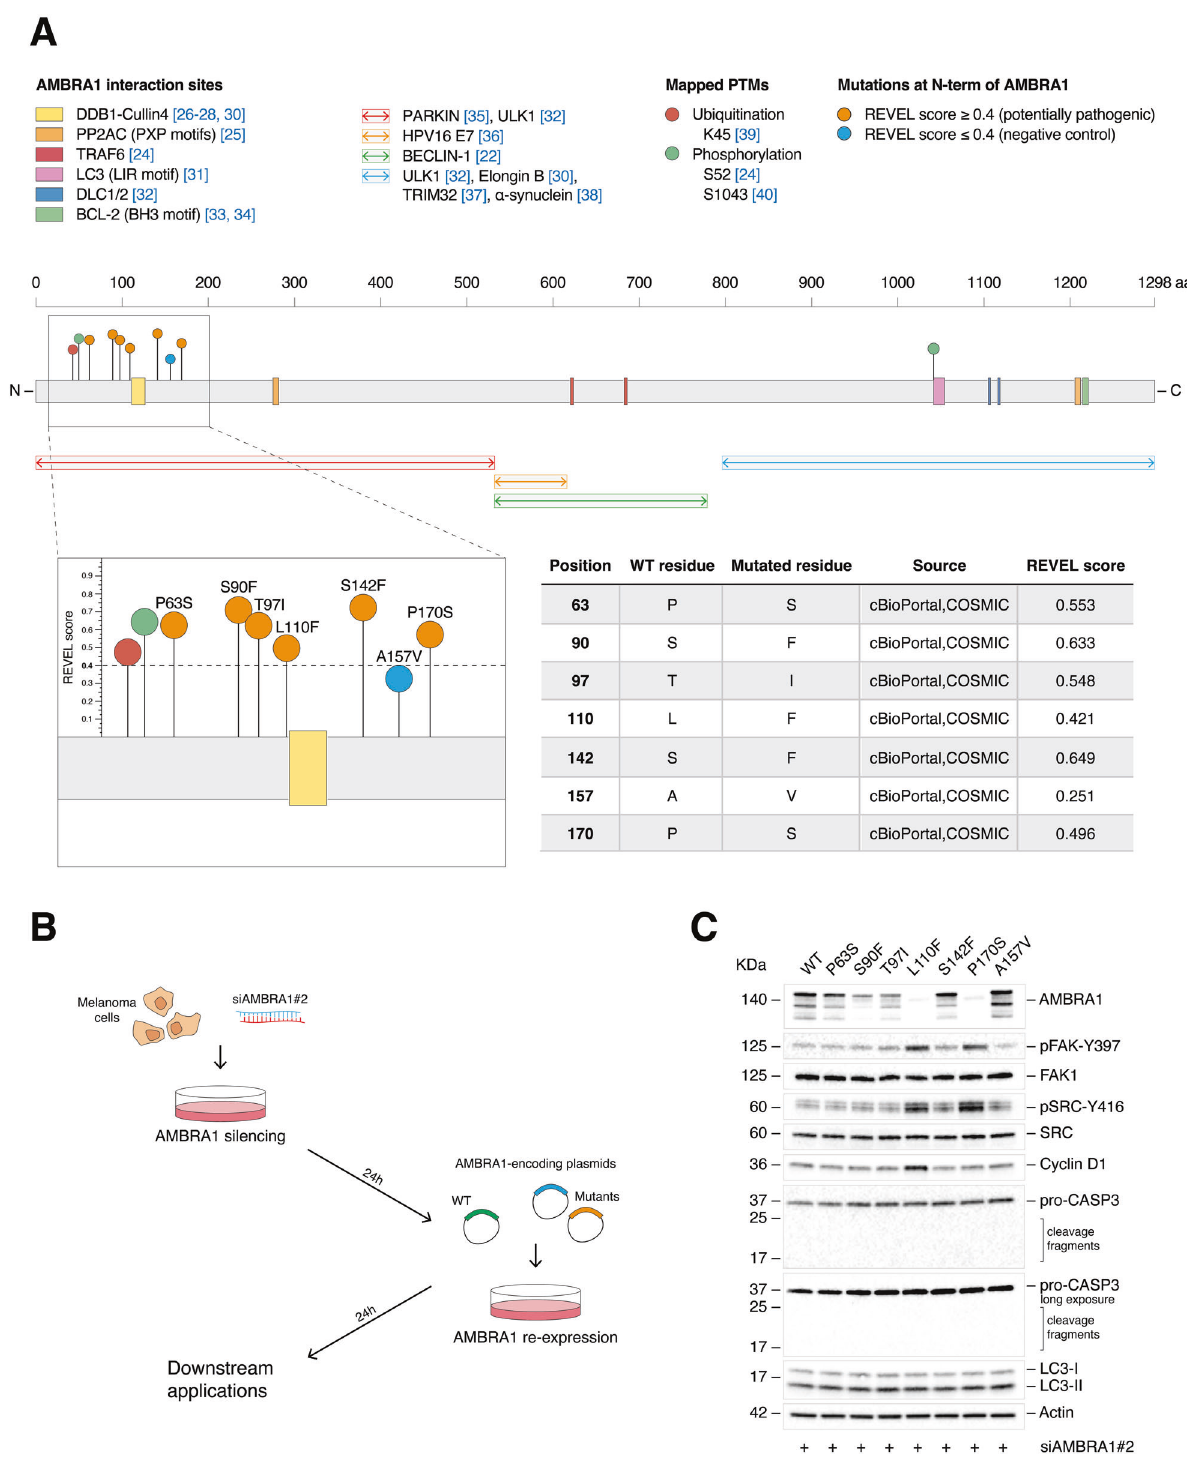
Fig. 3 Analysis of the effect(s) of the point mutations of AMBRA1 on its functions. A Schematic representation of AMBRA1 including interaction sites and PTMs identi fi ed experimentally. AMBRA1 mutations are also mapped and speci fi ed in the table to the right. B Schematic representation of the transfection strategy. C WB analysis of pFAK-Y397, FAK1, pSRC-Y416, SRC, Cyclin D1, pro-CASP3 (including cleaved fragments), and LC3 (-I and -II) in A375 melanoma cells re-expressing the P63S, S90F, T97I, L110F, S142F, and P170S AMBRA1 mutants. Re- expression of WT and A157V AMBRA1 was used as a reference and negative control, respectively. AMBRA1 and Actin were detected as transfection and loading control, respectively. Images are representative of n = 3 independent experiments.